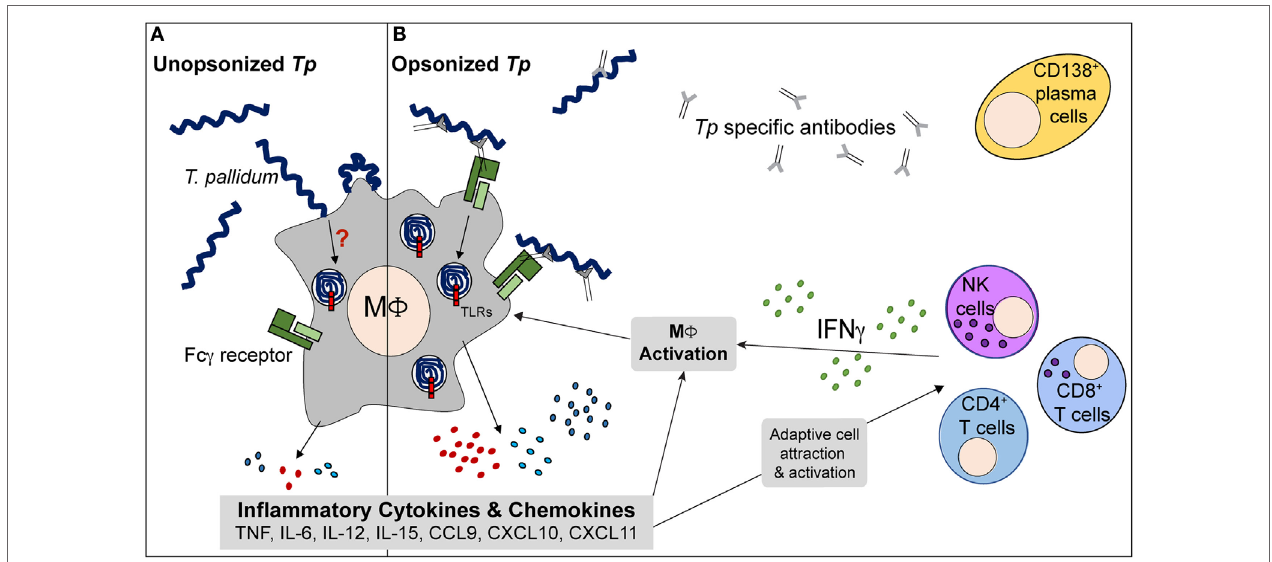
FigUre 8 | Proposed model of immune interplay in secondary syphilis (SS) lesions. (a) During early response to Tp , human macrophages (M Φ s) are able to bind unopsonized spirochetes but the cells phagocytose very limited numbers and many Tp are able to escape. The phagocytic process is inefficient and results in minimal inflammatory cytokine production. (B) Following antigen presentation by phagocytes, lymphocytes such as CD4 + T cells, CD8 + T cells, and NK cells produce IFN γ locally. T cell activation can aid in B cell maturation and Tp specific Ab production. The antibodies are directed to various targets of the treponemes, including the spirochete’s rare outer membrane proteins. M Φ s increase expression of Fc γ receptors (Fc γ Rs) in response to the IFN γ rich microenvironment of the infected tissue and allow for enhanced phagocytosis of opsonized treponemes. Within the M Φ s’ phagosomal compartment, the spirochetes’ fragile outer membrane is degraded, liberating the once concealed pattern-associated molecular patterns (PAMPs) and ultimately resulting in interaction with TLRs, such as TLR2 and TLR8. The activated M Φ s produce elevated levels of inflammatory cytokines (TNF, IL-12, and IL-15) and chemokines, resulting in an important positive feedback loop that acts on both branches of the immune system. Ultimately, with aid from the adaptive immune system, the macrophage plays a central role in clearance of Tp